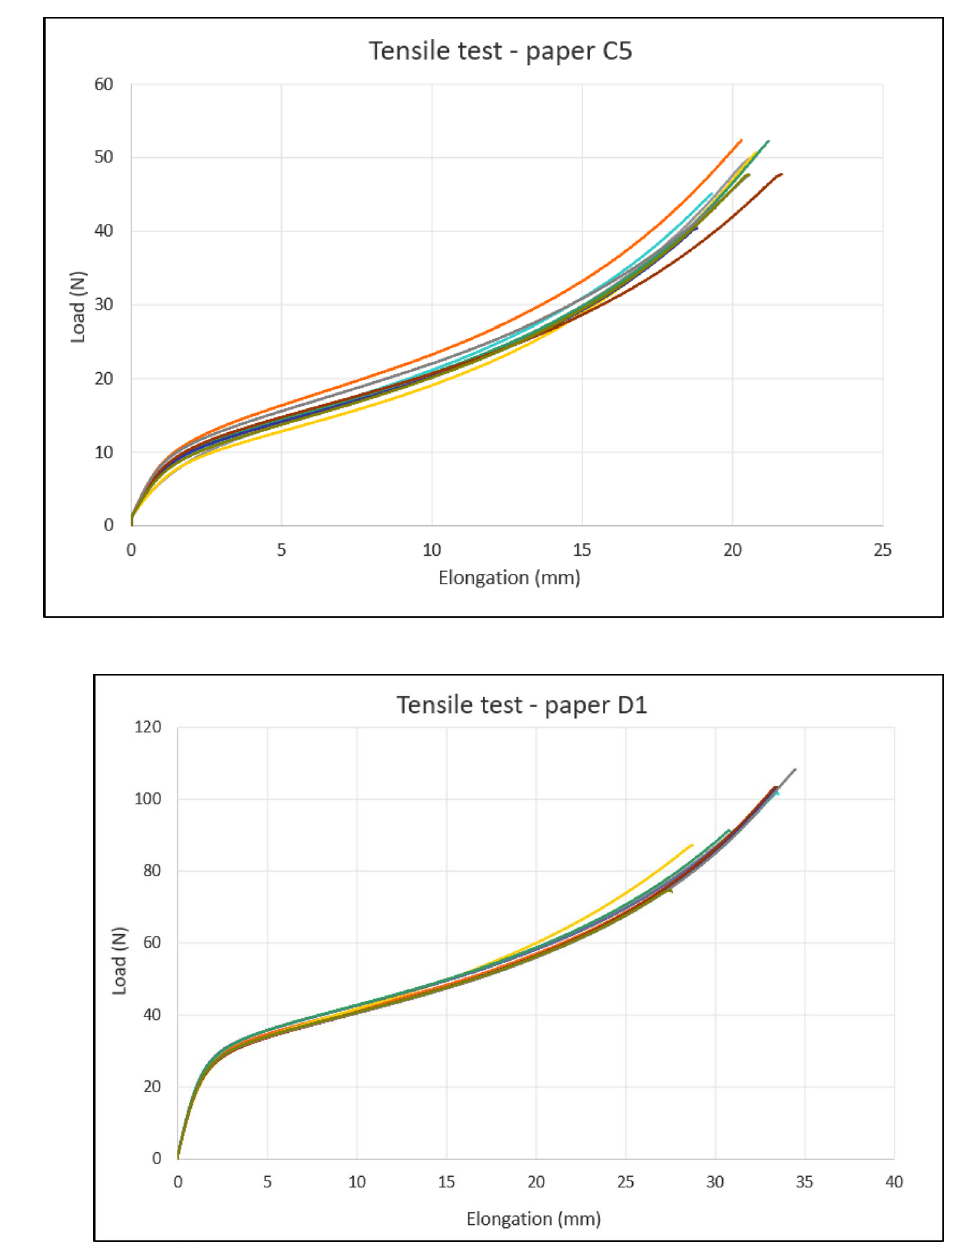
Fig. 30 Force elongation curves of individual specimen of paper C5